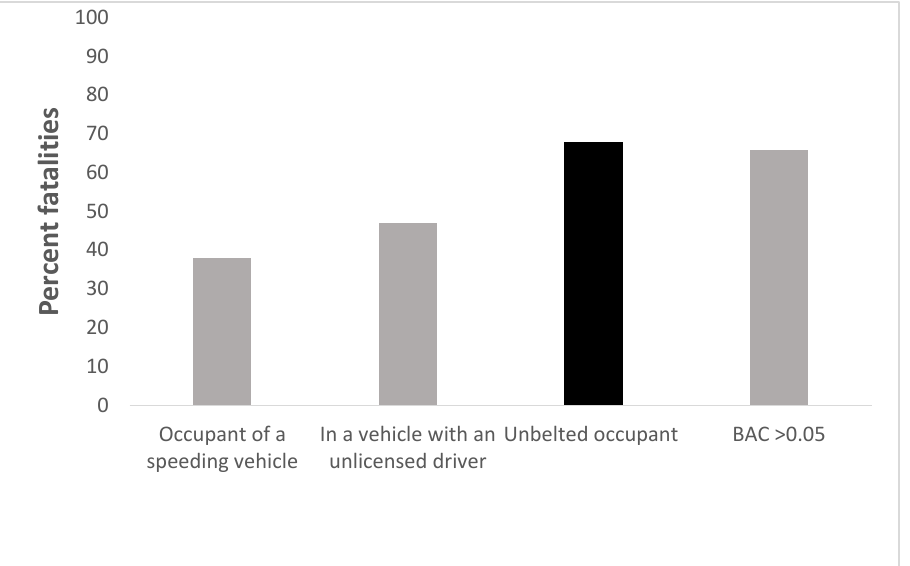
Figure 2. Percentage of road fatalities involving Indigenous peoples in the Northern Territory 1996 – 1999. Adapted from [70].